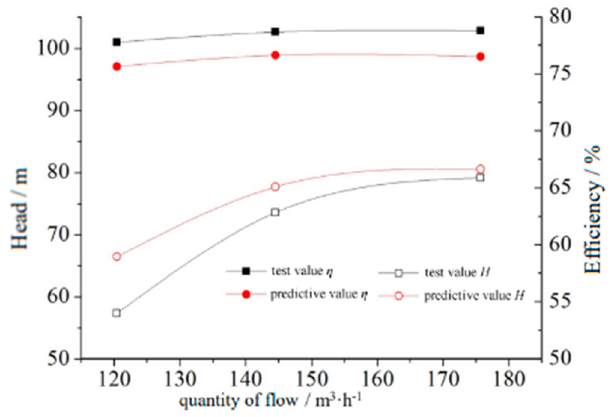
Figure 9. Comparison of the performance parameters of the vortex pump.